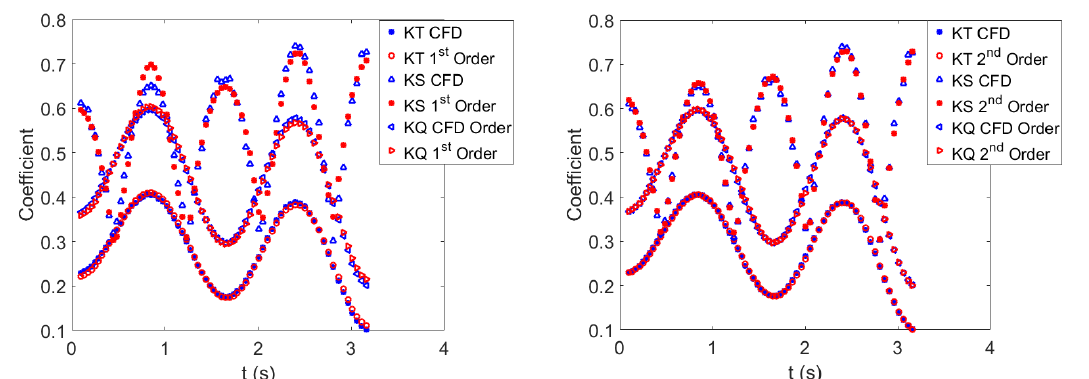
Figure 6. Coefficients as a function of time for open water training using nonlinear regression. ( Left ) Nonlinear regression using a first order feature vector. ( Right ) Nonlinear regression using the second order feature vector.